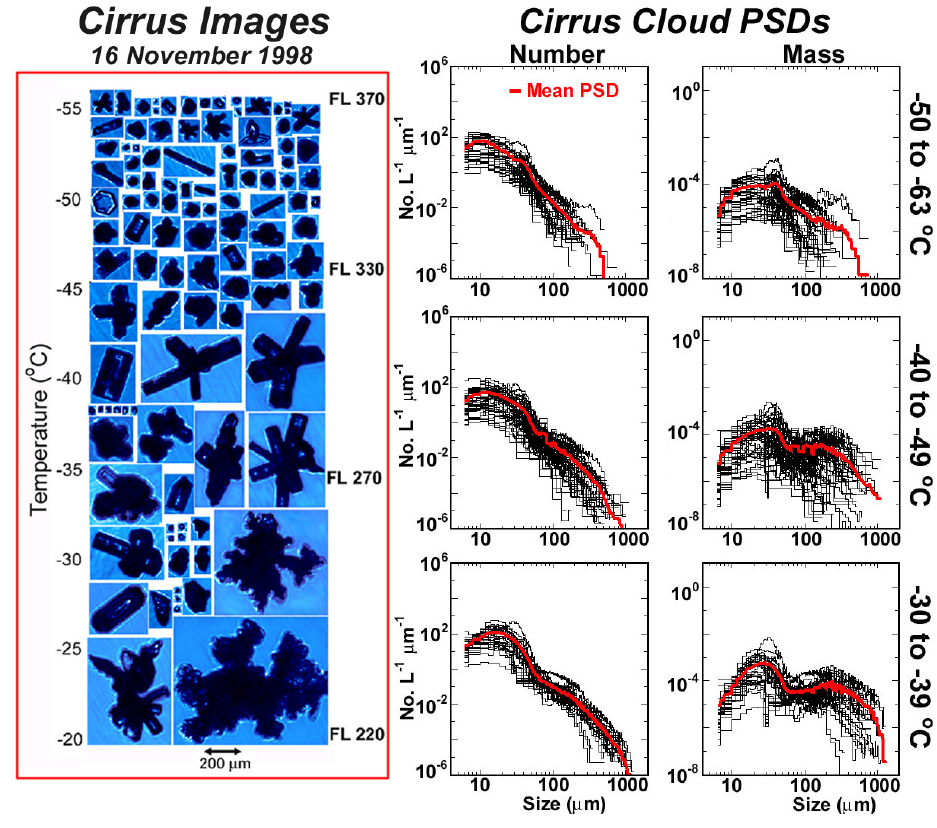
Figure 1. Example of (left) vertical profile of CPI images in a deep orographically generated cirrus, and (middle and right panels) number and mass particle size distributions for three temperature ranges generated from 102 horizontal legs in cirrus, where average size distributions are shown in red. Small end of the size distributions are based on measurements from FSSP and large end from 2D-C probe, with CPI data scaled to fit in between. Adapted from Lawson et al. (2006b).